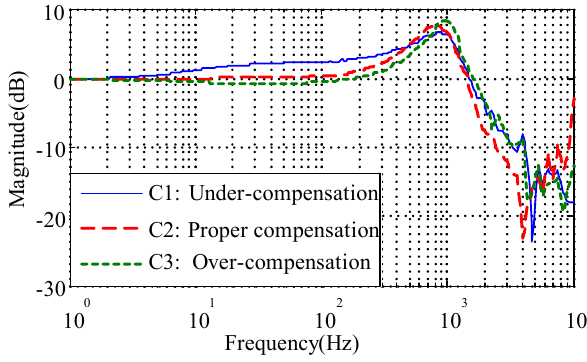
Figure 10. Close-loop frequency responses with different stiffness compensations.